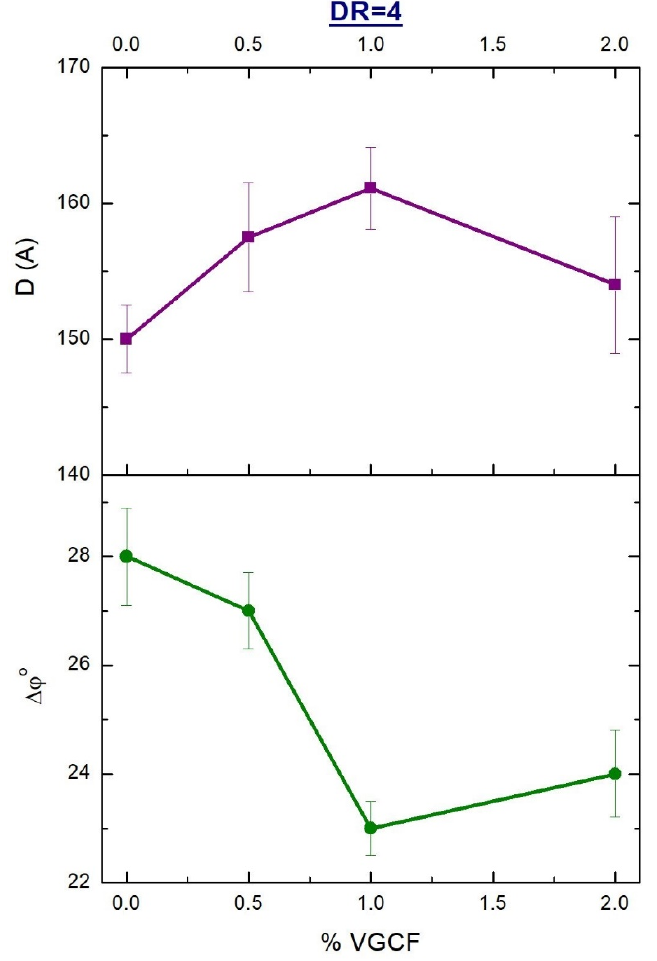
Figure 7. Dependences of the transverse size and misorientation angle (along the fiber axis) of the crystallites on the content of the nanoparticles in the ultimately oriented (DR = 4) composite fibers based on R-BAPB.